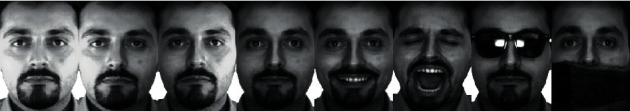
Samples in the AR dataset.